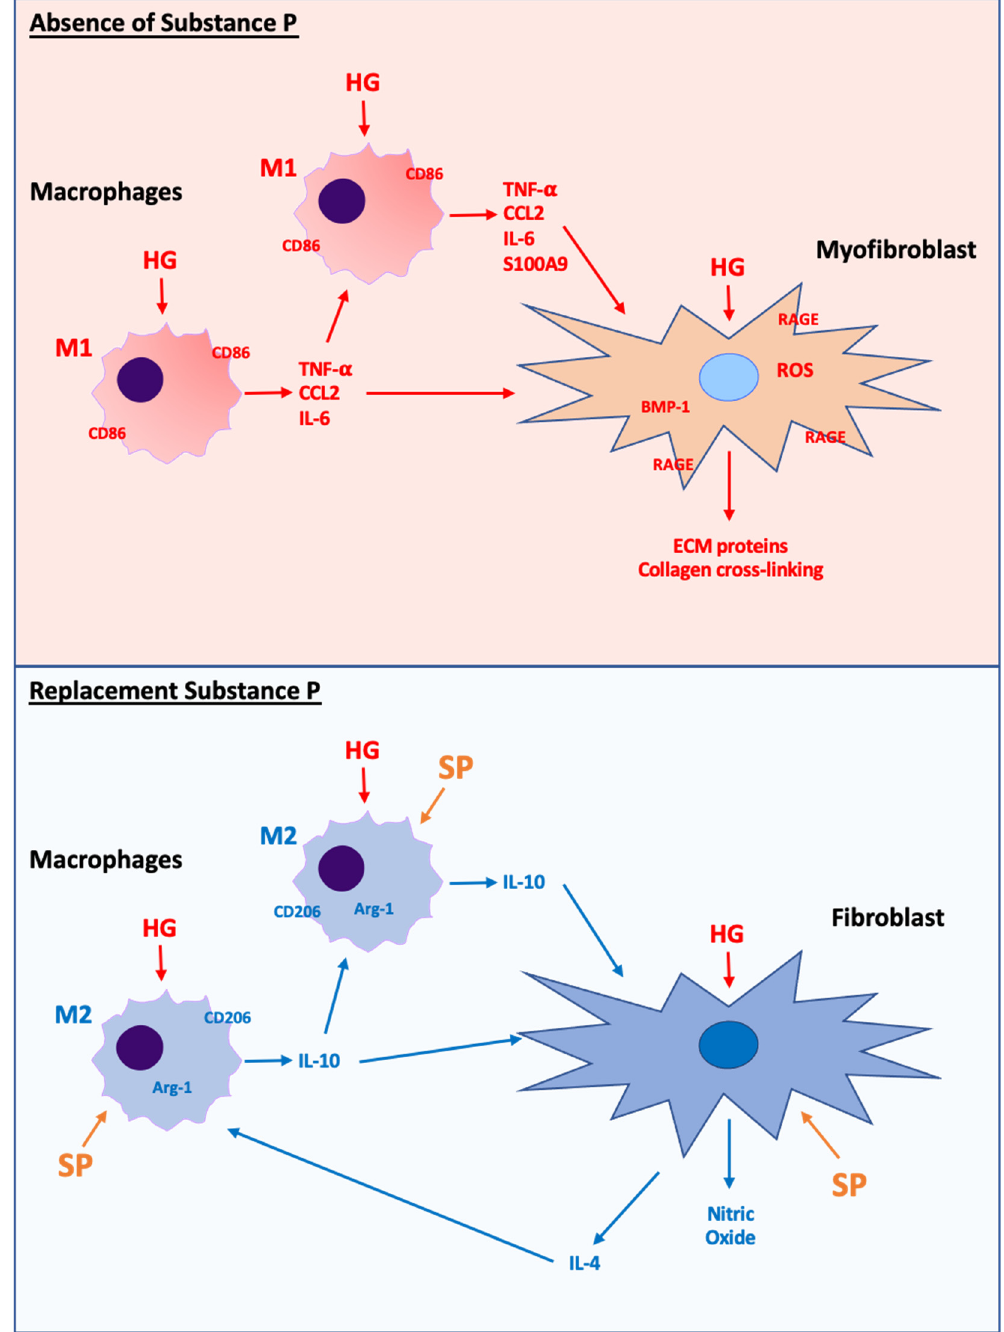
Figure 7. Schematic showing proposed macrophage and fibroblast phenotype responses to high glucose conditions in the absence of SP (upper panel) and high glucose conditions with replacement SP (lower panel). Under conditions of high glucose in the absence of SP, macrophages take on a pro-inflammatory M1 phenotype that releases pro-inflammatory cytokines (TNF- α , CCL2, IL-6), which can act on fibroblasts to promote a pro-fibrotic phenotype by overwhelming reparative M2 macrophages. High glucose in the absence of SP also acts directly at the fibroblast to promote a pro-fibrotic phenotype mediated by increased RAGE, oxidative stress, and inflammatory cytokines (TNF- α ). Conversely, when SP is present in addition to high glucose, M1 macrophages are reduced and M2 macrophages become the dominant macrophage phenotype. M2 macrophages release the anti-fibrotic cytokine IL-10. Additionally, the presence of SP opposes the pro-fibrotic fibroblast phenotype by reducing RAGE and oxidative stress, as well as increasing NO production. In response to SP, cardiac fibroblasts also produce IL-4, which can act as an additional stimulus for M2 macrophage